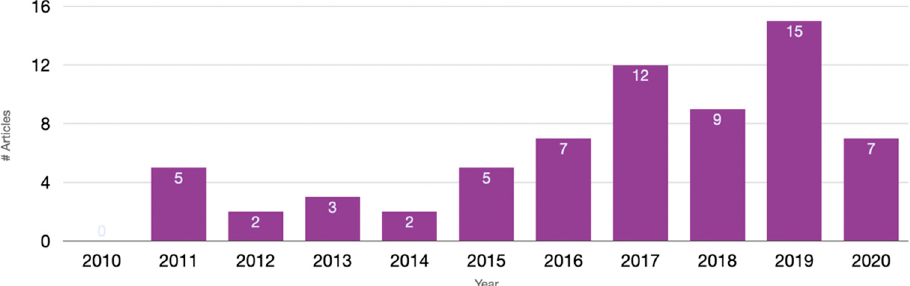
Figure 3. Number of articles per year.